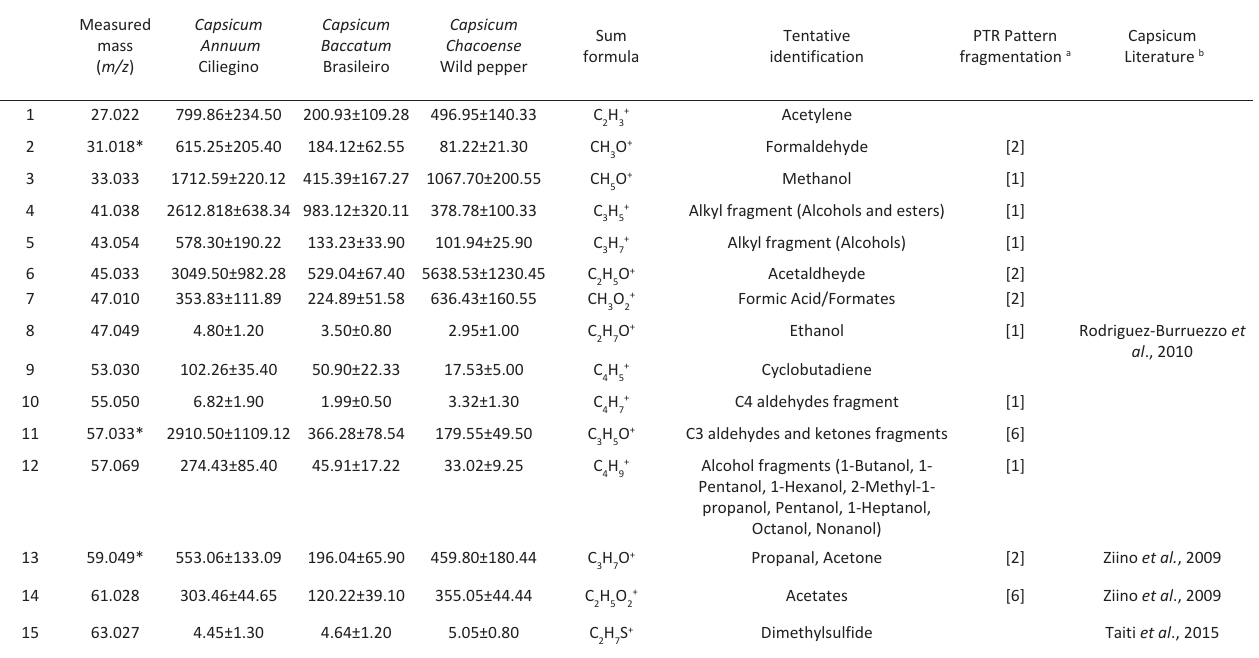
Table 2 ­ List of the average m/z­signals that can be specifically assigned using H O + as reagent ion: Volatile Organic Compounds 3 headspace intensity expressed in ncps (n=10; ±SD); chemical formulae and tentative identifications for each signals detected; the compounds identification was linked to the PTR­ToF­MS pattern fragmentation references (a) or previously reported